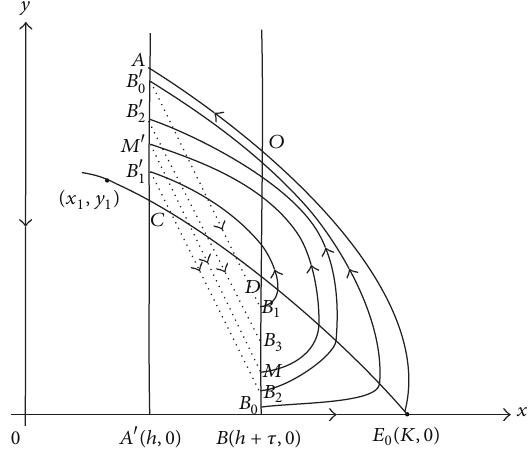
Figure 4: Illustration of the orbital asymptotic stability of the order one periodic solution of the system